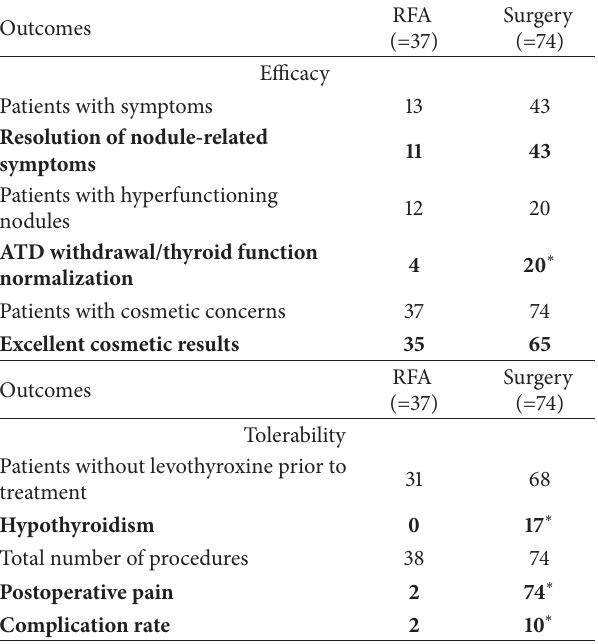
Table 2: Efficacy and tolerability of RFA compared to